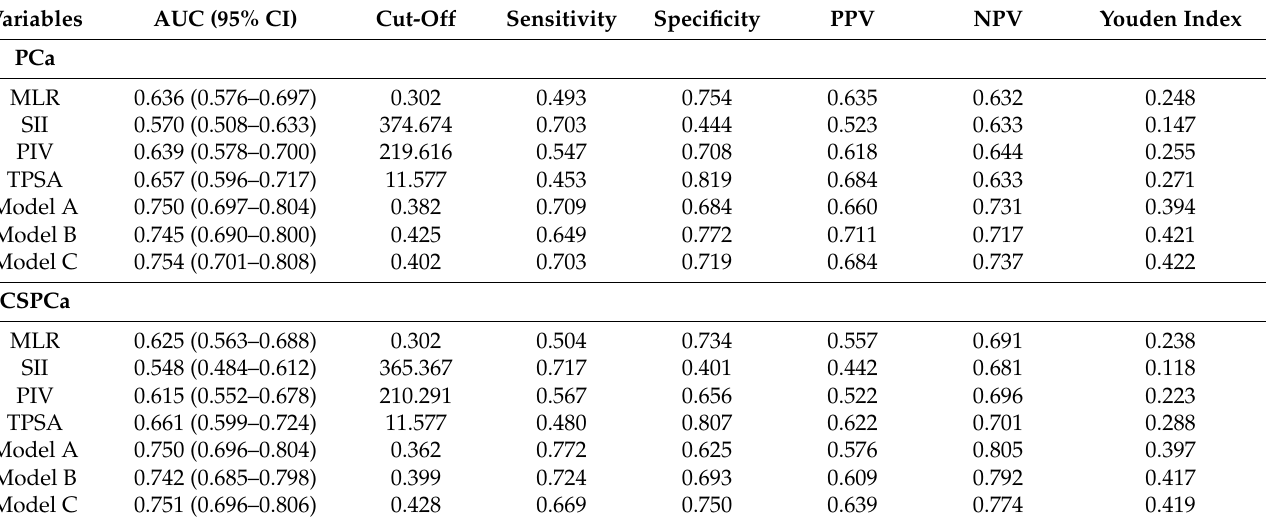
Table 4. ROC curve analysis of